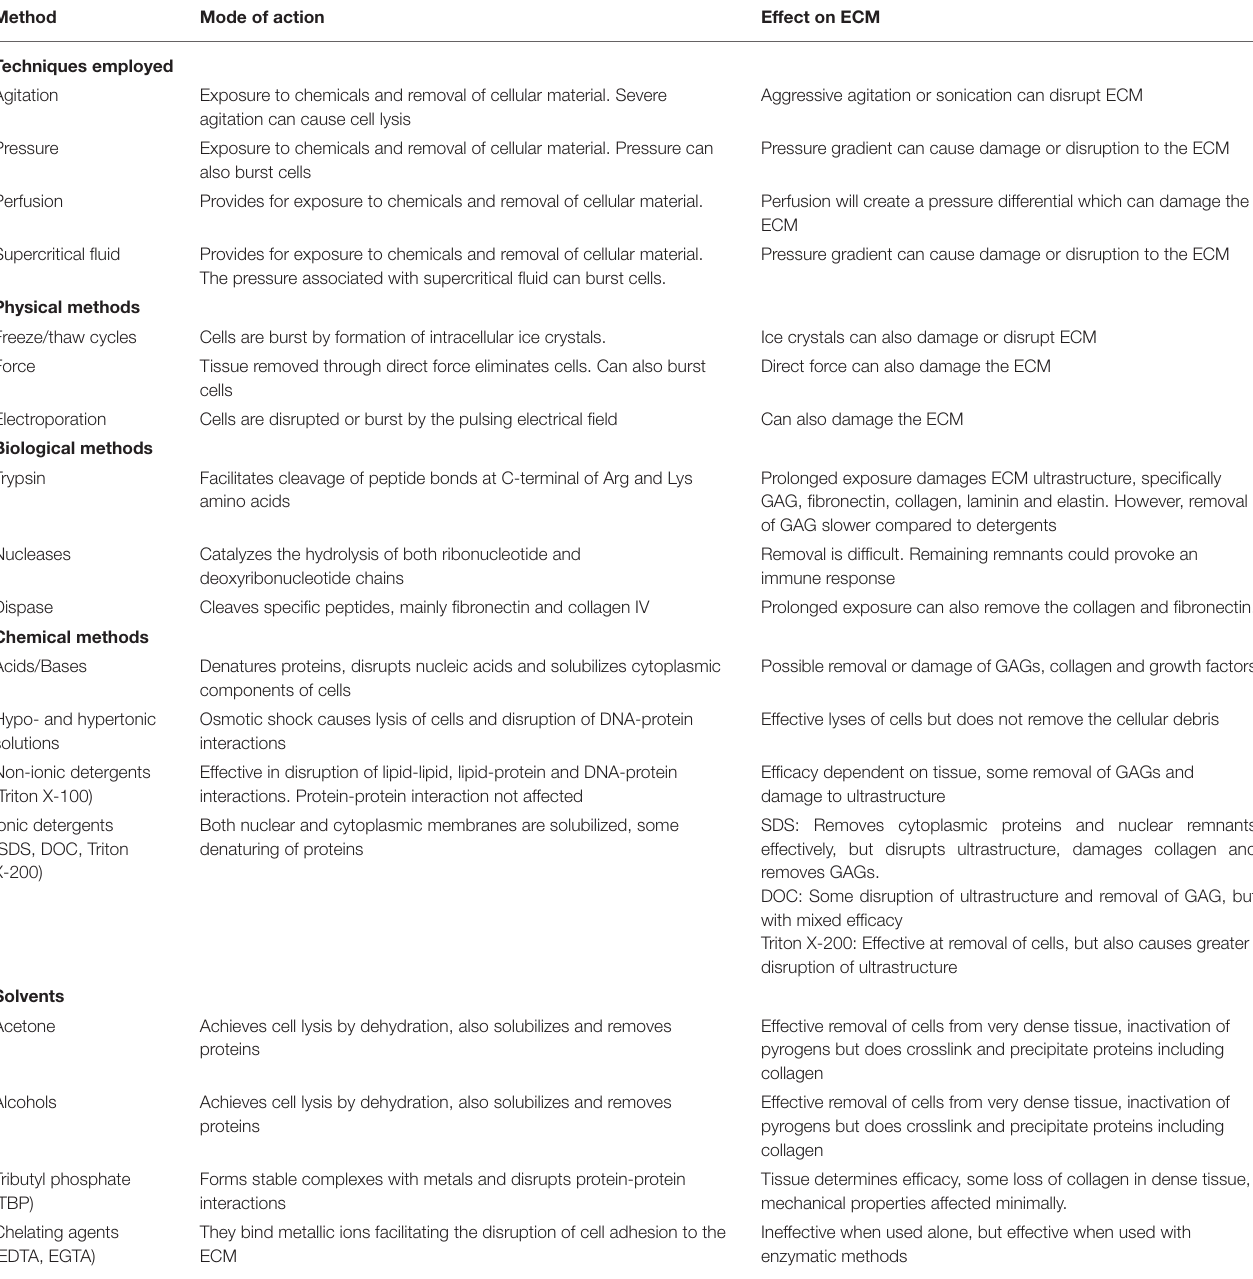
TABLE 1 | Summary of decellularization techniques, their modes of action and effects on the extracellular matrix (ECM) Includes data from Gilbert et al. (162) and Crapo et al.